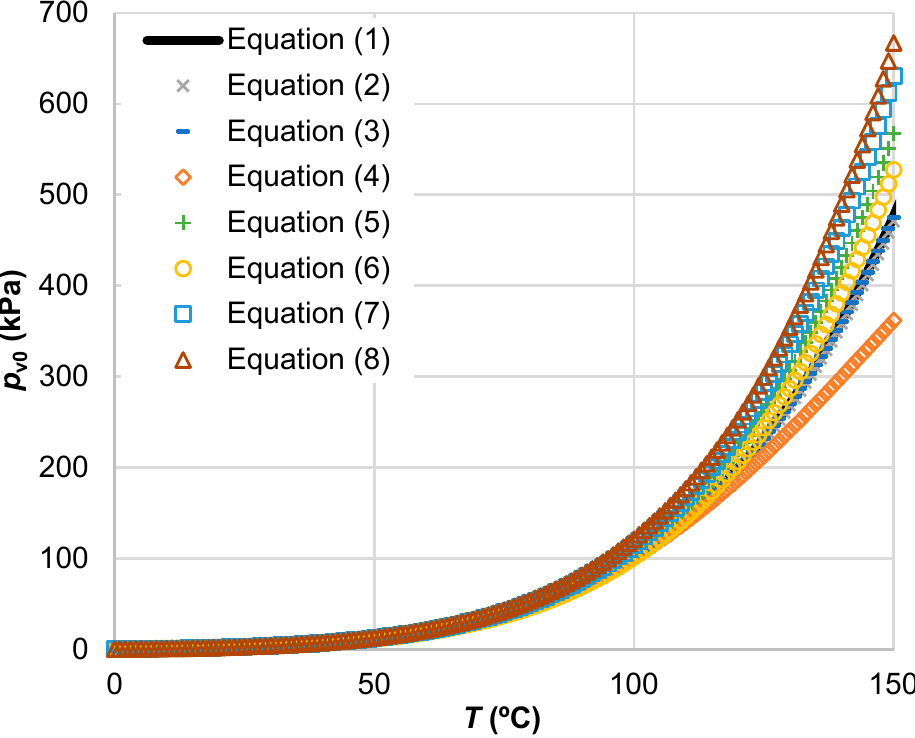
Figure 1. Saturated water vapour pressure as a function of temperature in the temperature range 0–150 °C for the different formulations analysed, Equations (1)–(8) [4–12]. Note that the results of Equations (2) and (3) practically overlap with the reference values of Equation (1).